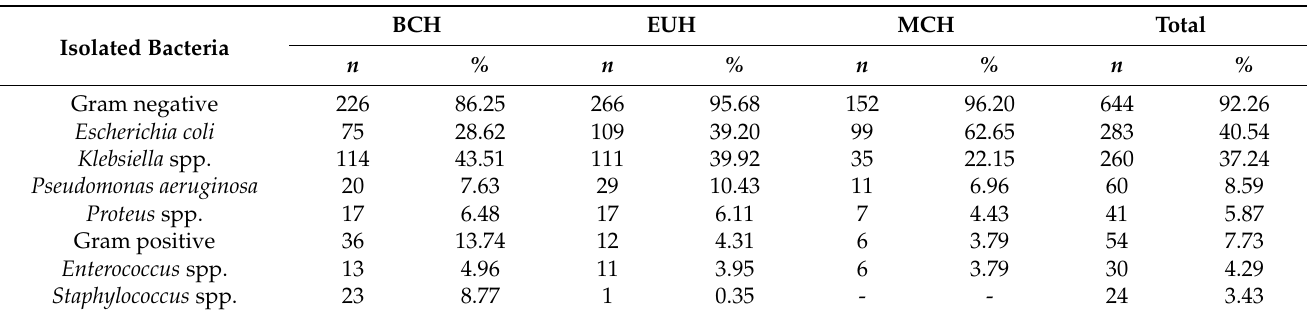
Table 1. MDR isolated uropathogens.